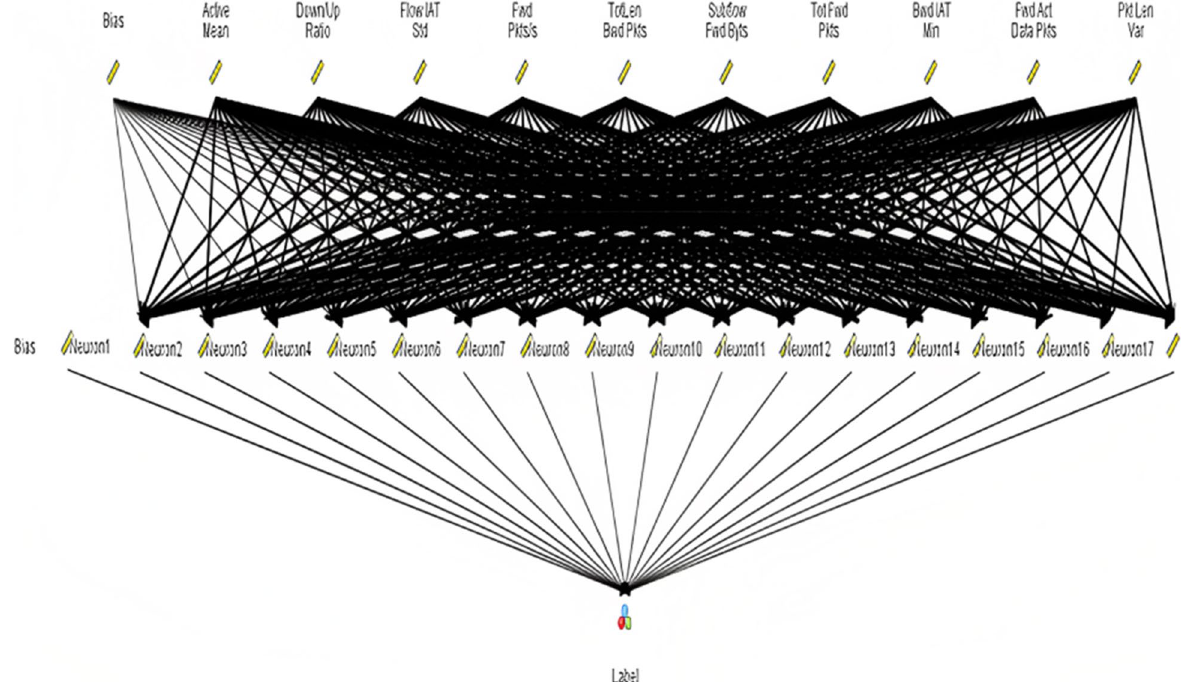
Fig. 6 Neural network for the current